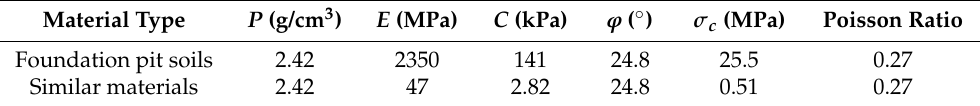
Table 5. Mechanical parameters of the raw soils and the similar material.